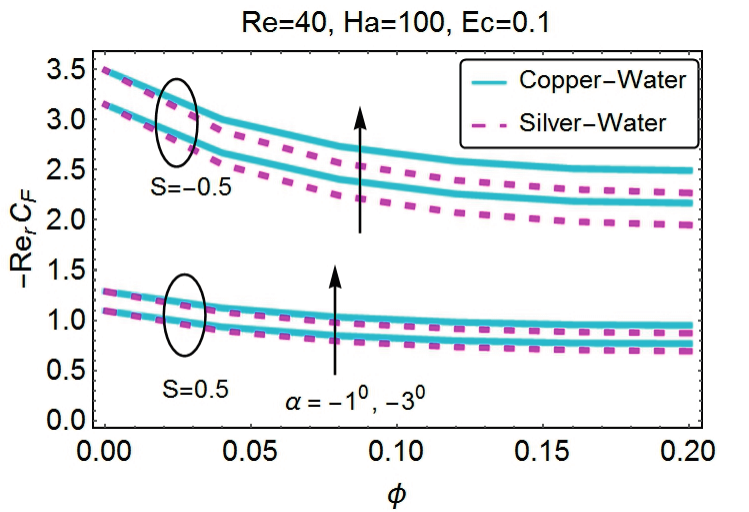
Figure 29. Variation in the skin friction coefficient with the angle and the nanoparticle volume fraction (convergent